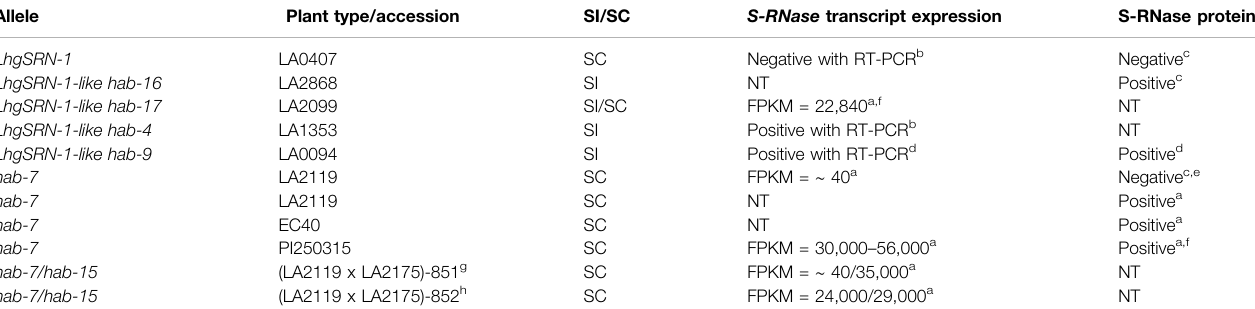
TABLE 2| Expression ofsilenced/expressed S-RNase alleles inSCand SI S. habrochaites populations. Transcriptional expression wasanalyzed byeitherRT-PCR or RNA- seq analysis using stylar RNA. S-RNase protein was analyzed by immunoblotting with stylar protein extracts. NT (cid:1) not tested. a This study, b Covey et al., 2010, c Broz et al., 2017, d Broz et al., 2021, e Multiple individuals tested negative, and a single individual tested positive, f This population segregates for hab-7 and LhgSRN-1 , and all individuals tested that contained hab-7 were positive for hab-7 mRNA with RNA-seq and for S-RNase protein with immunoblotting ( Supplementary Figure S15 ), g Two clones ofthisplantweregrown ineitherthe fi eldor inagrowth chamber and gaveidenticalresults, h Thisplant wasageneticsiblingofplant (LA2119 xLA2175)-851 and was grown in the greenhouse.